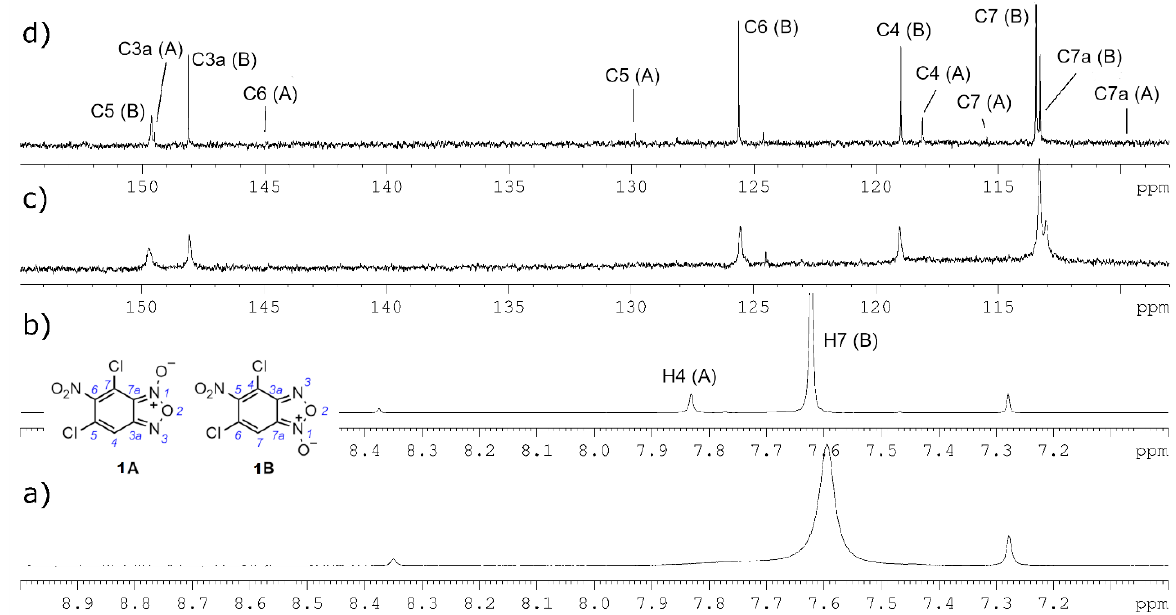
Figure 4. The 1 H and 13 C NMR spectra of compound 1 , CDCl 3 : ( a ) 1 H, 303 K; ( b ) 1 H, 253 K; ( c ) 13 C, 303 K; ( d ) 13 C, 253 K. NMR experiments allowed for establishing C-H connectivities for a part of the mol- ecule. However, the earlier utilized level of theory was used again in order to accomplish